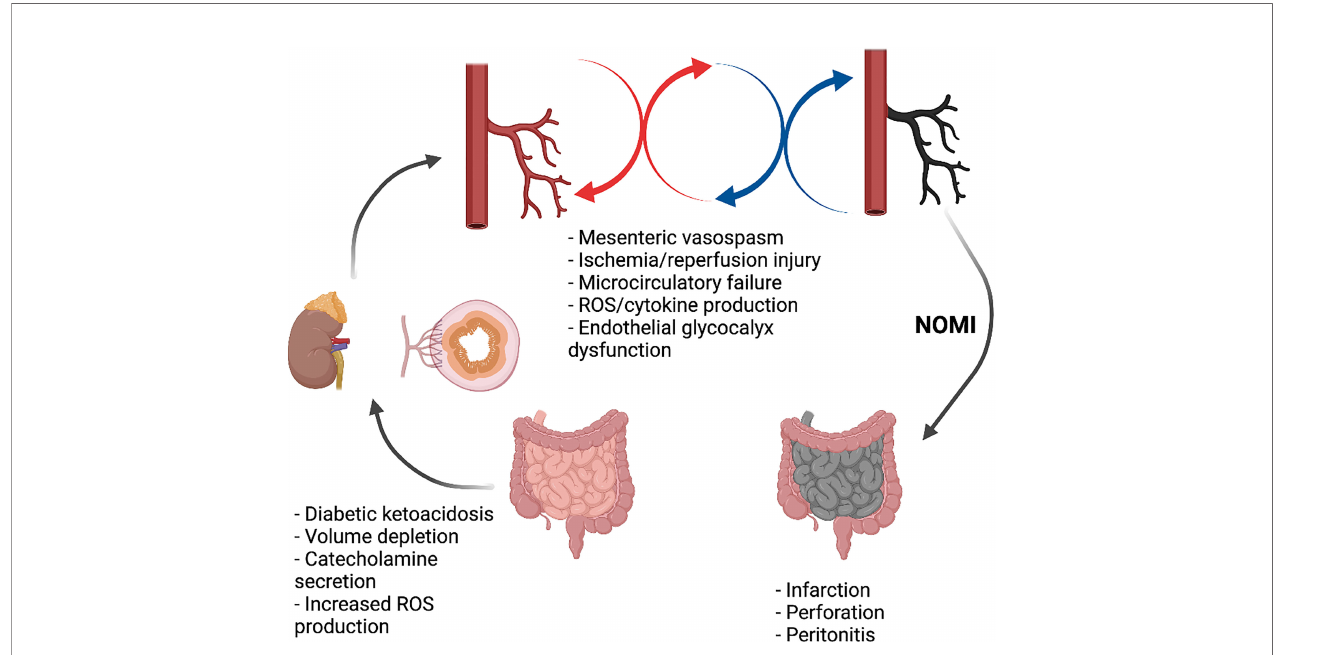
FIGURE 2 | Non-occlusive mesenteric ischemia in DKA. Created with BioRender.com.